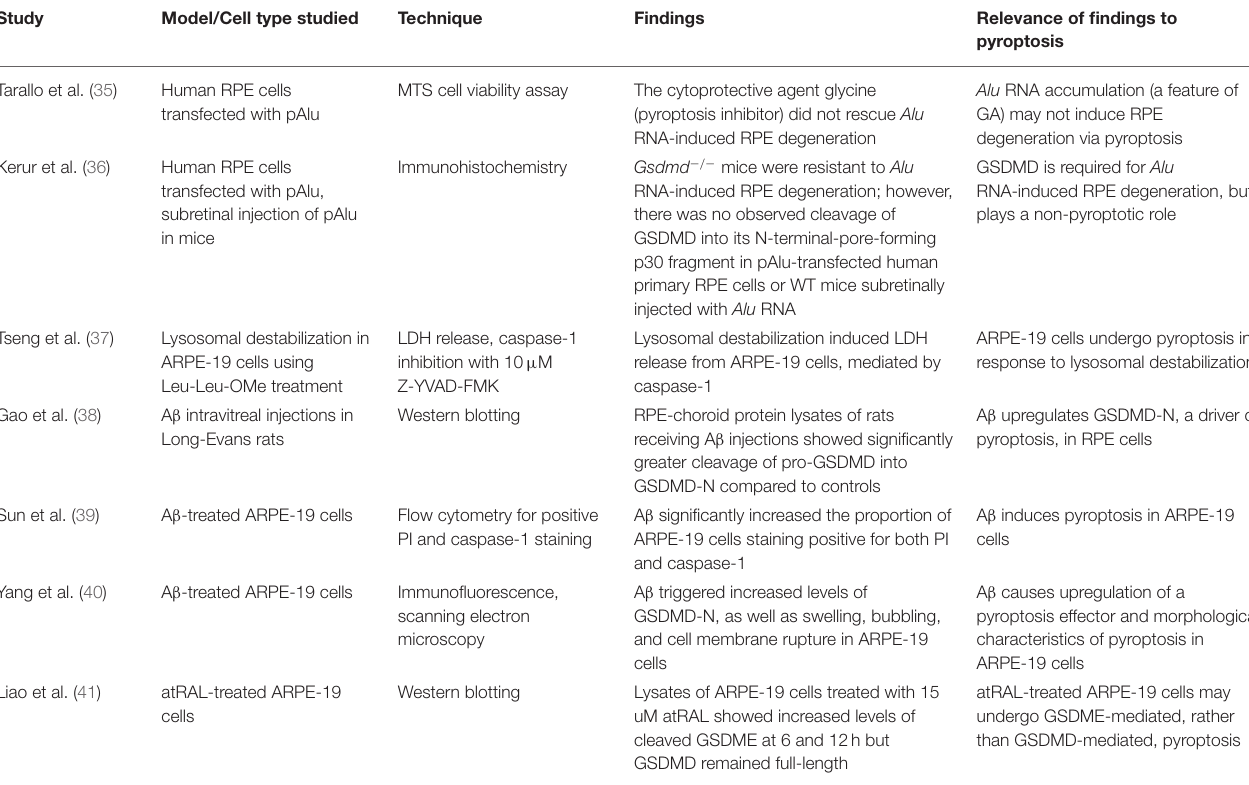
TABLE 1 | Studies investigating pyroptosis in